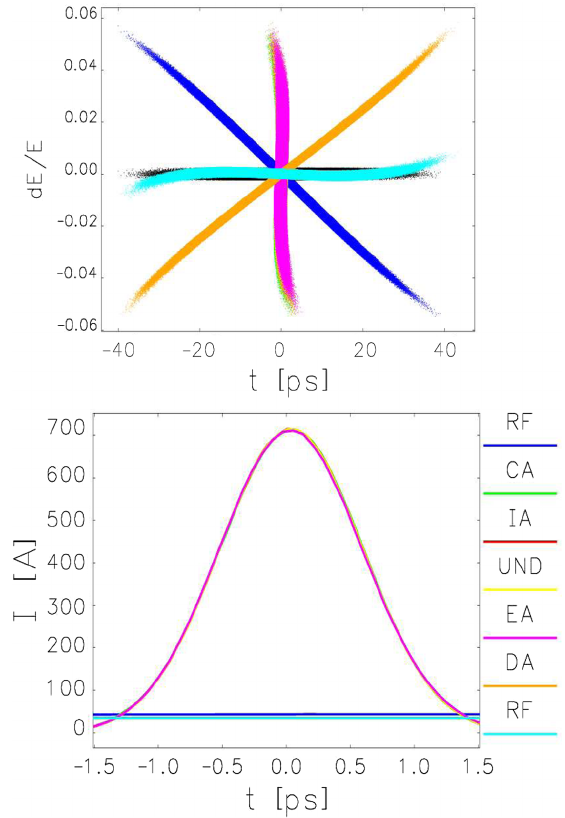
FIG. 3. Longitudinal phase space (top) and bunch peak current through one loop. The colored legend is the same in the two plots; labels refer to Fig.